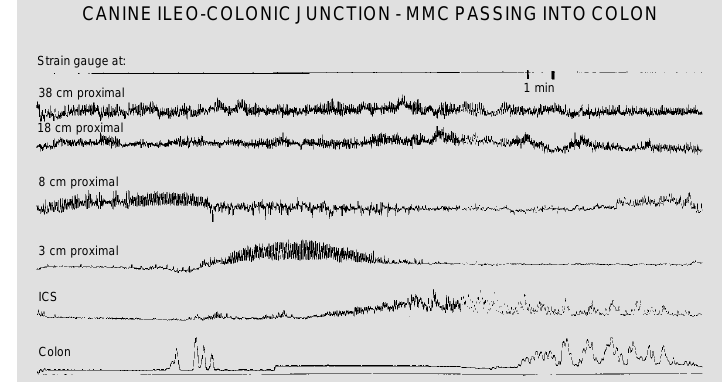
Figure 3 - Fasting motor activity of canine ileo-colonic junction. Note phase 3 of the migrating motor complex migrating through the distal ileum, across the ileocecal sphincter (ICS) into the colon.